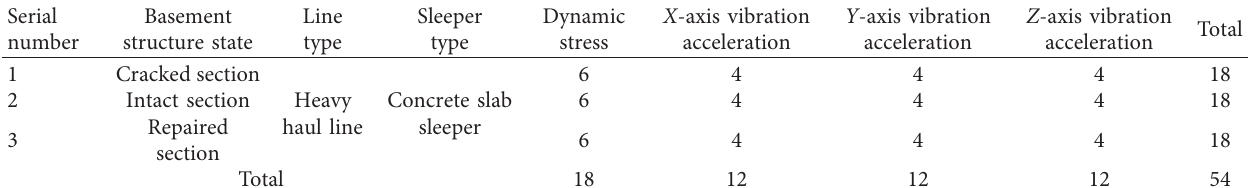
Table 1: Test contents and number of test points for tunnel structure test.